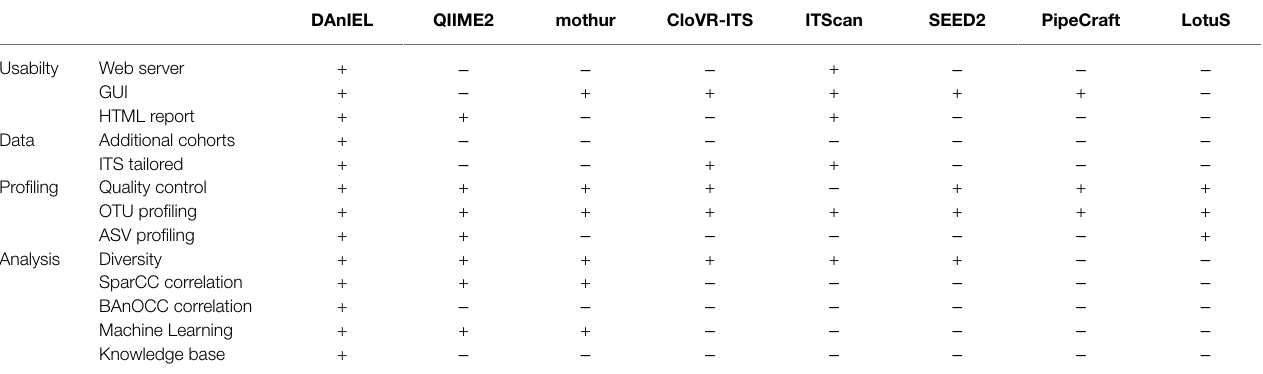
TABLE 1 | Functionality of software for ITS